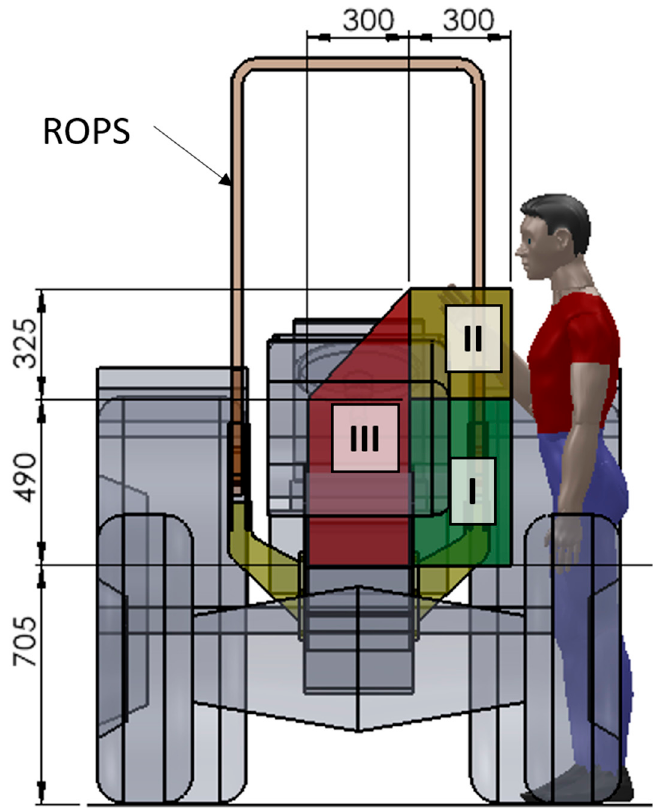
Figure 2. Scheme of the accessible zones of the grasping area considering a wheeled tractor where measures are expressed in mm (elaborated from